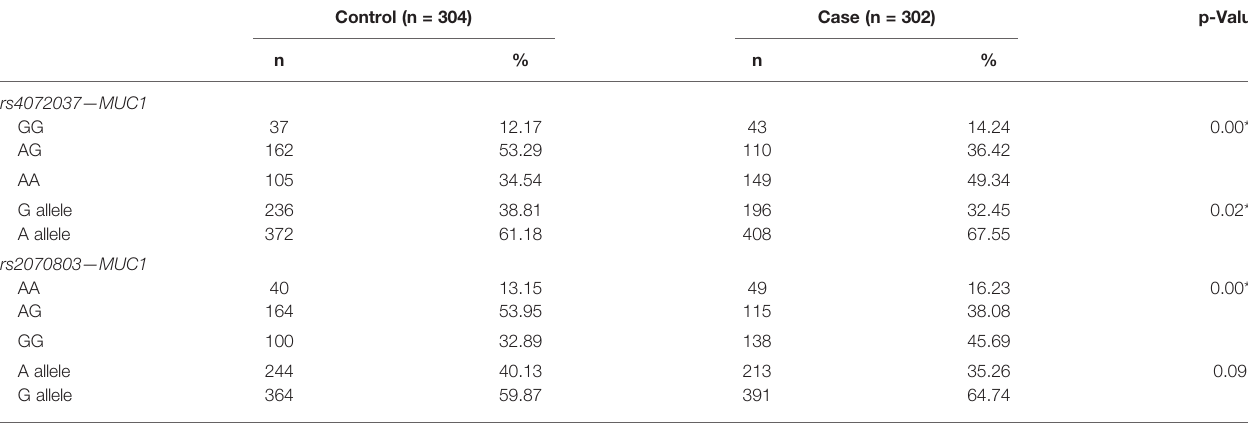
TABLE 4 | Difference of the genotypes and allele distribution of rs4072037 and rs2070803 between gastric cancer cases and controls. Control (n = 304)